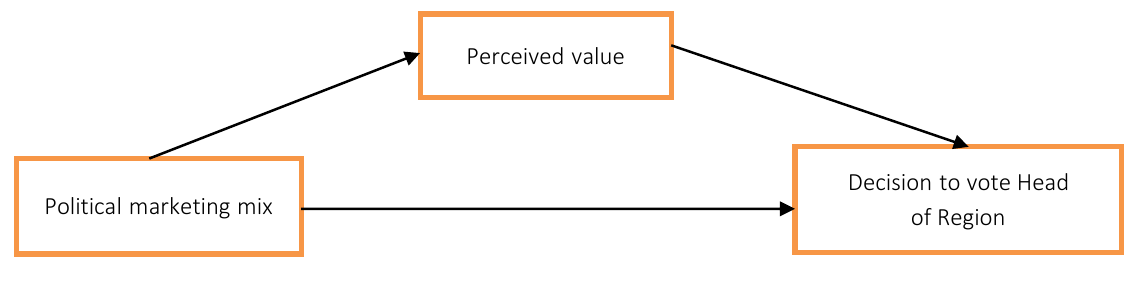
Figure 1. Conceptual